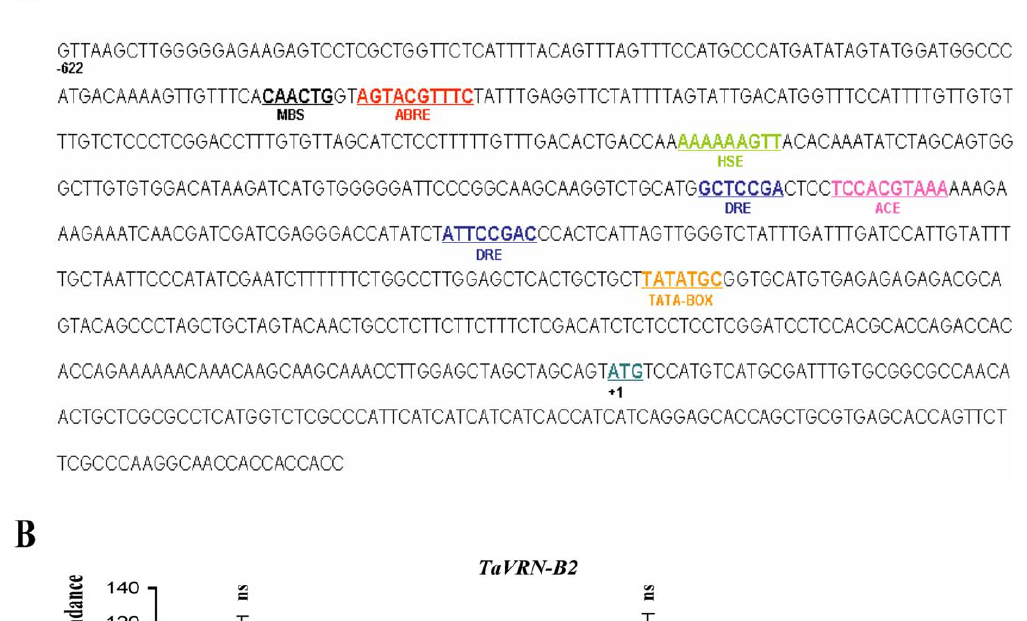
to the third generation. Homozygous plants of the fourth generation were analysed (Fig. 4). The flowering time was measured by the number of rosettes of leaves when flowering occurs. The results show that this number was 10 leaves for control plants, and 15, 13 and 12 leaves for line1, line2 and line3 respectively (Fig. 4C). This flowering time was delayed by 7 days (P , 0.01) in line 1 and 5 days in line 2 and 3 when grown under long day conditions confirming that the strength of delay of flowering was consistent with the transgene expression level (Fig. 4). Effect of TaVRN-B2 expression on flowering initiation and development is shown in Fig. 4A. All control plants initiated flower buds and flower formation after 24 and 28 days respectively compared to the three transgenic lines. After 35 days the midflower formation is completed in control plants while the trangenic lines still at stage of flower formation. This demonstrates